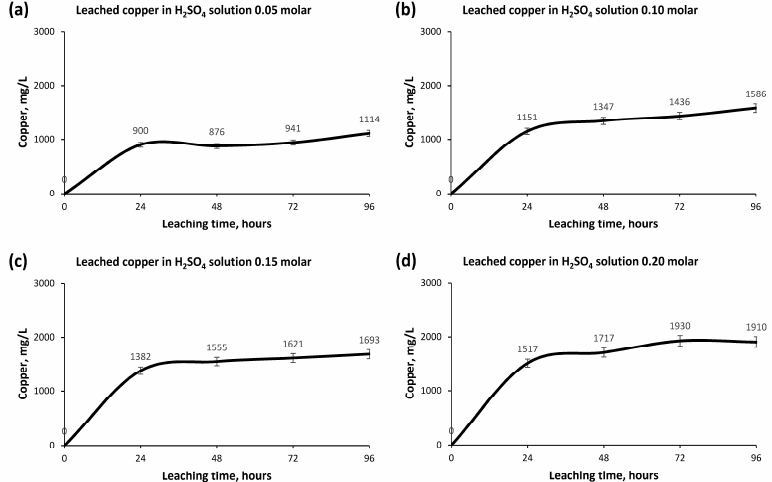
Figure 3. Analysis of Copper concentration in the leaching process at atmospheric pressure, ambient temperature and in di ff erent Sulphuric Acid solutions: ( a ) 0.05 molar H 2 SO 4 solution, ( b ) 0.10 molar H 2 SO 4 solution, ( c ) 0.15 molar H 2 SO 4 solution, ( d ) 0.20 molar H 2 SO 4 solution.